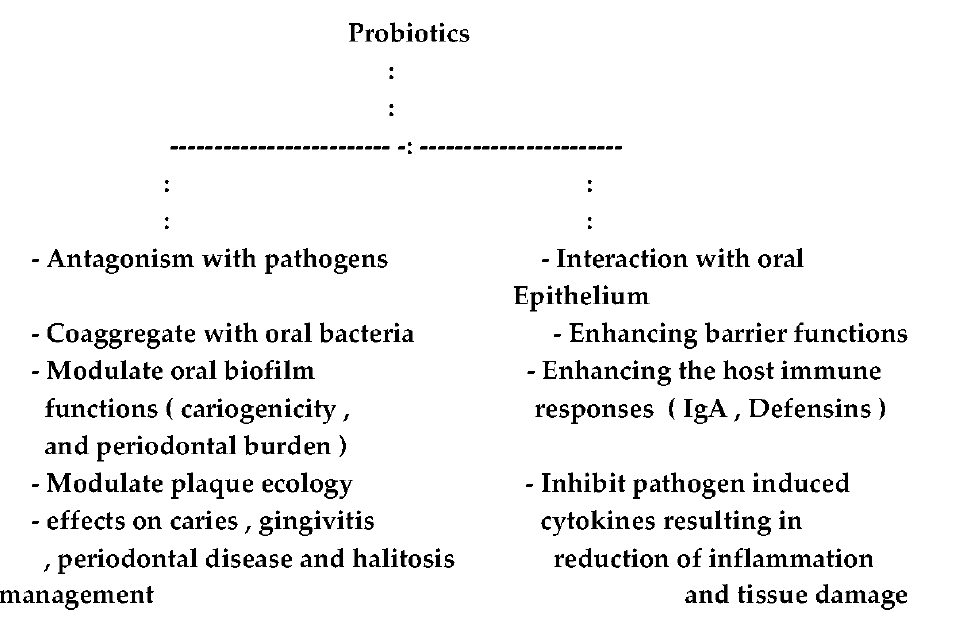
Figure 1. The envisaged probiotic roles in the oral cavity.